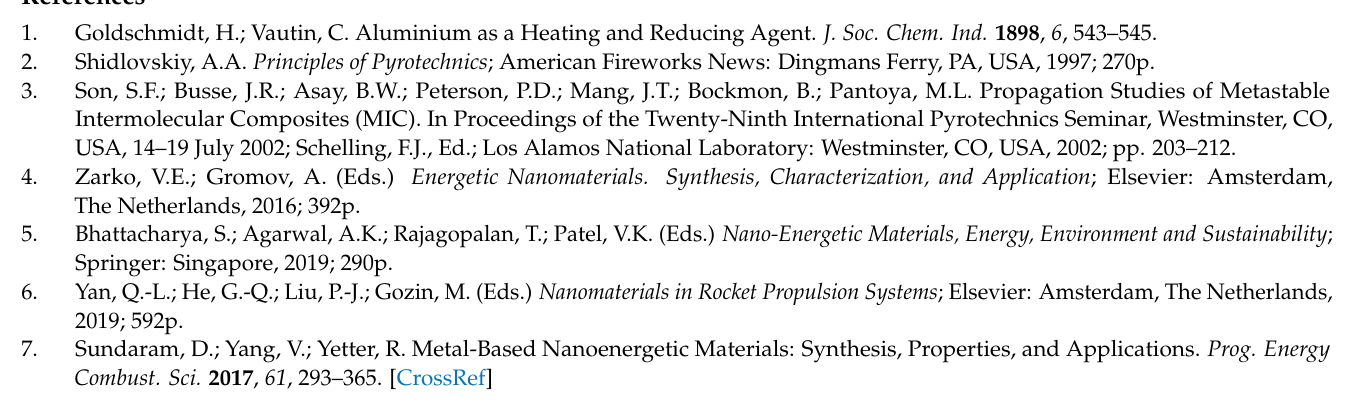
Zone 4, Figure S6: Zone 5, Figure S7: Zone